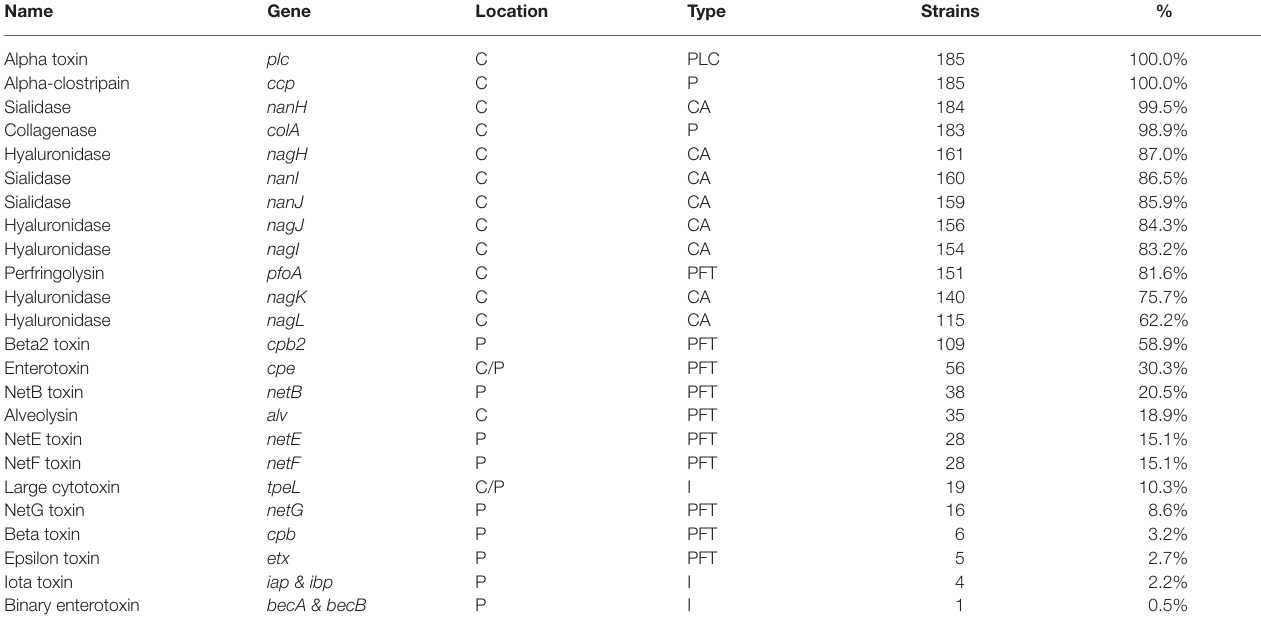
TABLE 1 | Prevalence of toxin and virulence genes in 185 Clostridium perfringens genomes together with information on location [chromosome (C) or a plasmid (P)] as well as the type of protein encoded [membrane-damaging phospholipase (PLC), pore-forming toxin (PFT), intracellular toxin (I), protease (P), or carbohydrate-active enzyme